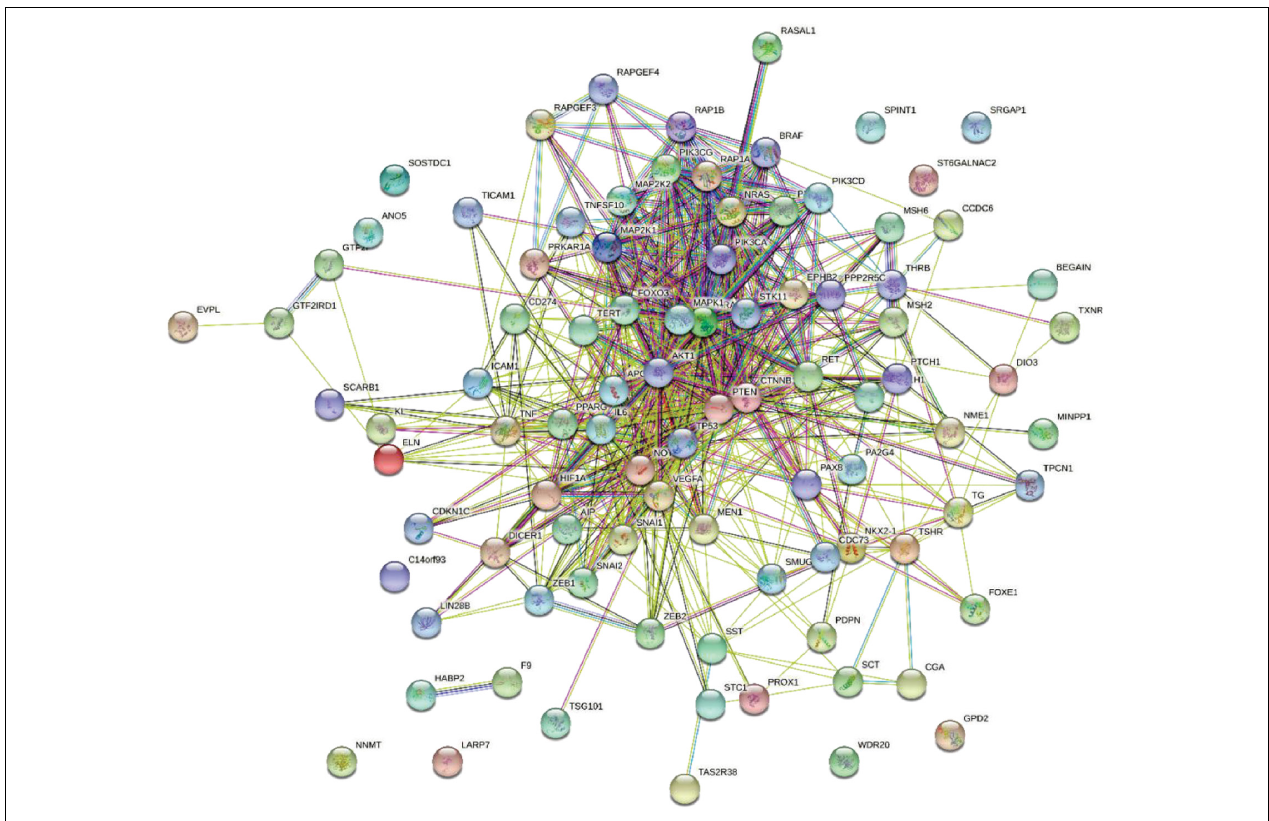
FIGURE 2 | Gene interaction network of TC-related genes.